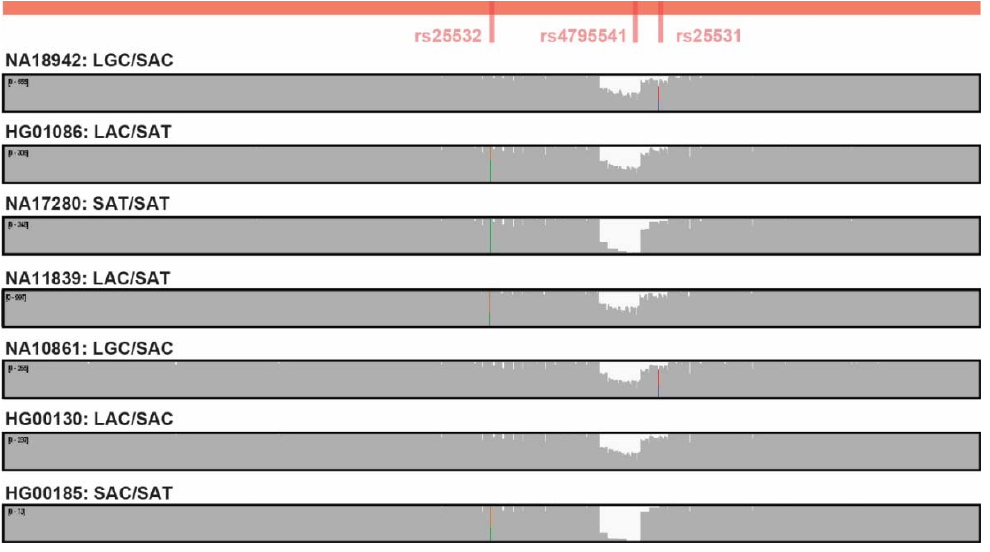
Figure 2. Representative SLC6A4 promoter sequencing results from seven Coriell DNA samples using long ‐ read SMRT sequencing: NA18942 (LGC/SAC), HG01086 (LAC/SAT), NA17280 SAT/SAT, NA11839 (LAC/SAT), NA10861 (LGC/SAC), HG00130 (LAC/SAC), HG00185 (SAC/SAT).